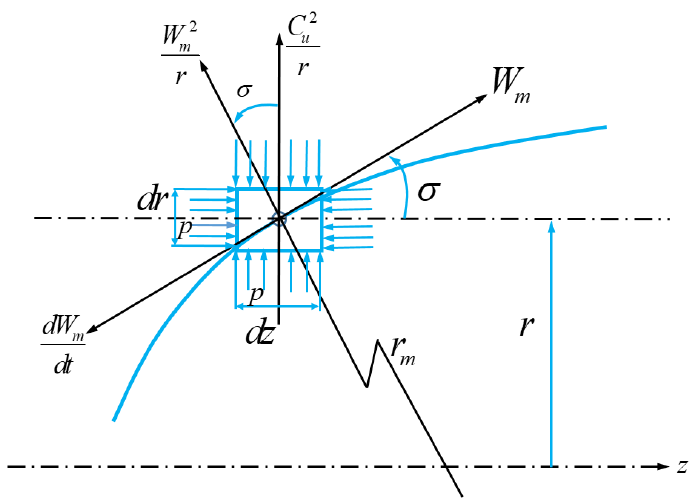
Figure 7. Force analysis in the radial balance equation.